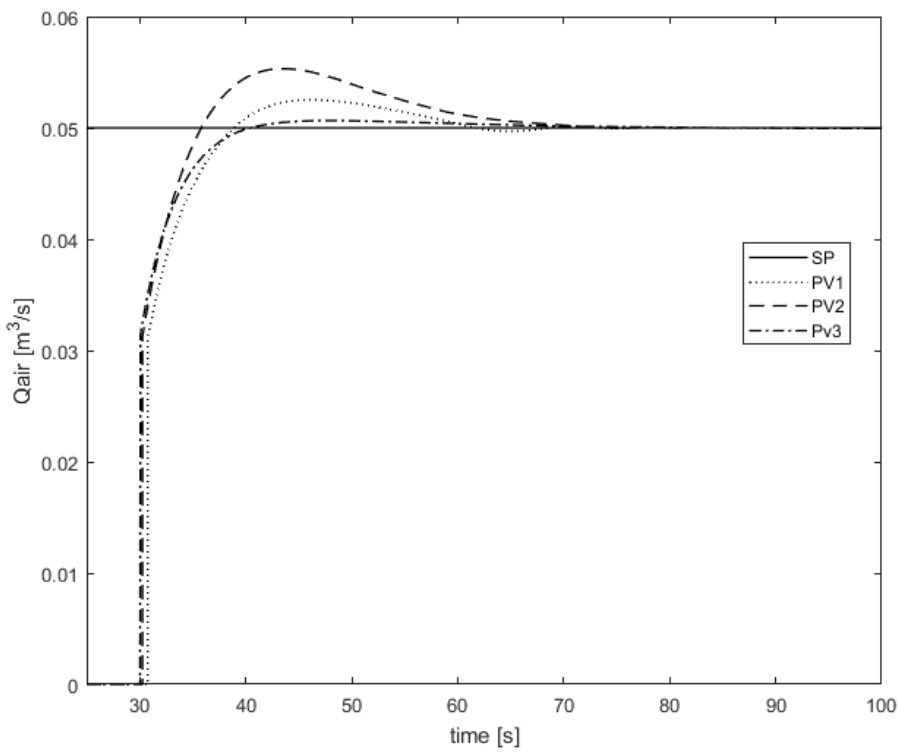
Figure 11. Step response of the third fuzzy control system.